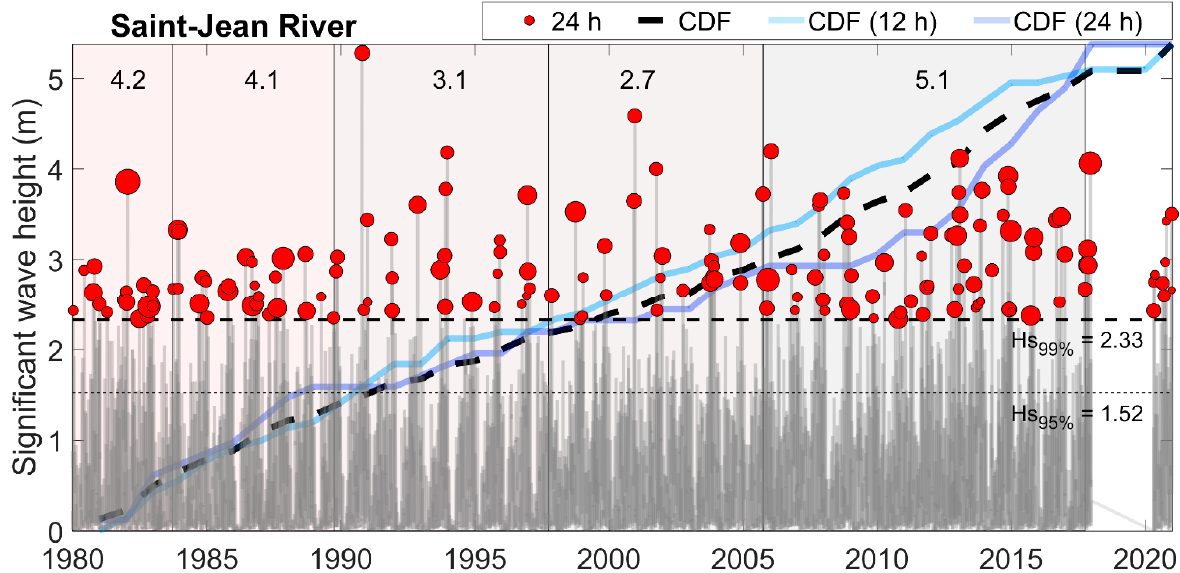
Figure 22. Storm detection over 1980–2020. Each red circle represents a storm, the size of which is a function of the storm duration. Transparent gray line is the significant wave height time series; 99th and 95th percentile thresholds are displayed. The cumulative distribution functions (CDF) of storm events are shown for all storms (dashed black line), storm durations between 12 and 24 h (clear blue dashed line) and above 24 h (deep blue dashed line). The different time intervals (1980–1983; 1983–1989; 1989–1997; 1997–2005; 2005–2017) are highlighted with vertical black lines and the number of events per year is indicated for each interval.